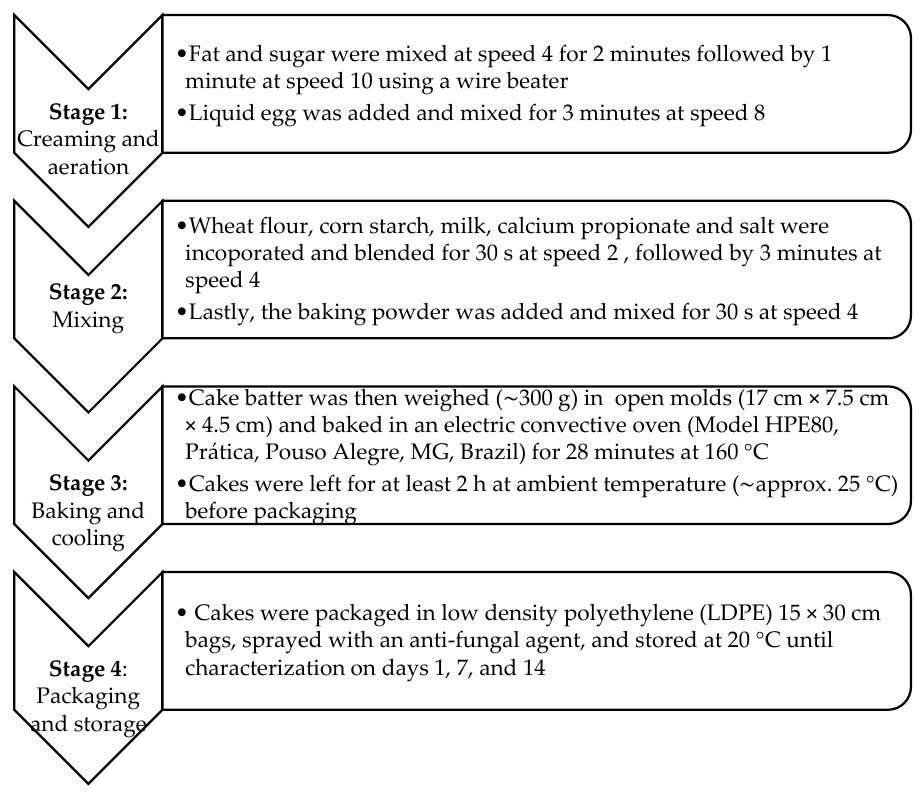
Figure 1. Flow diagram of the cake preparation multi-stage process. The anti-fungal agent consisted of 400 mL extra hydrated neutral alcohol, 100 mL deionized water, 1.35 g citric acid, 4.25 g sorbic acid, and 3.75 g propylene glycol.